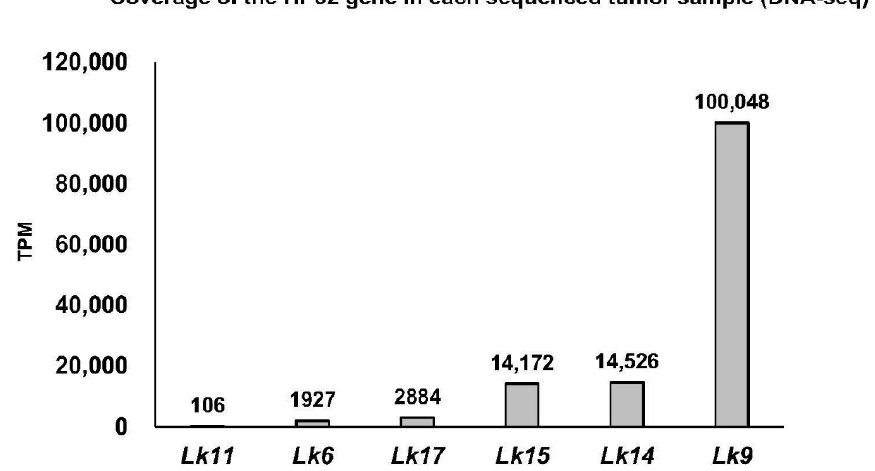
Figure 5. Coverage of chelonid alphaherpesvirus 5 (ChHV5) hypothetical protein-32 (HP32) gene